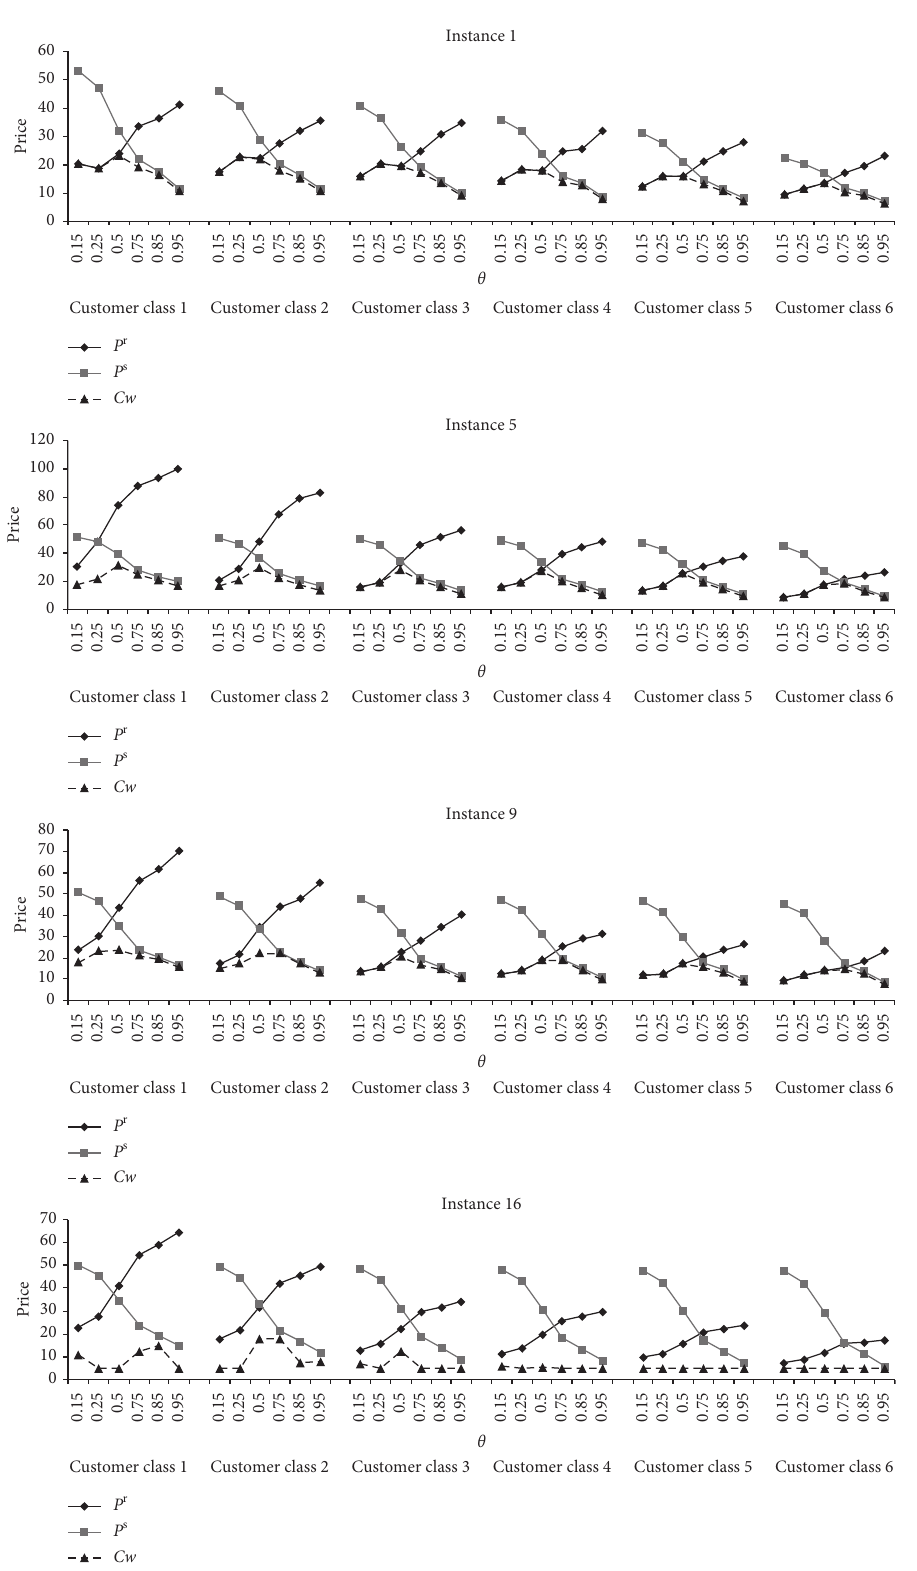
Figure 5: Comparison of the retail price, direct sale price, and wholesale price in decentralized dual-channel supply chain for different